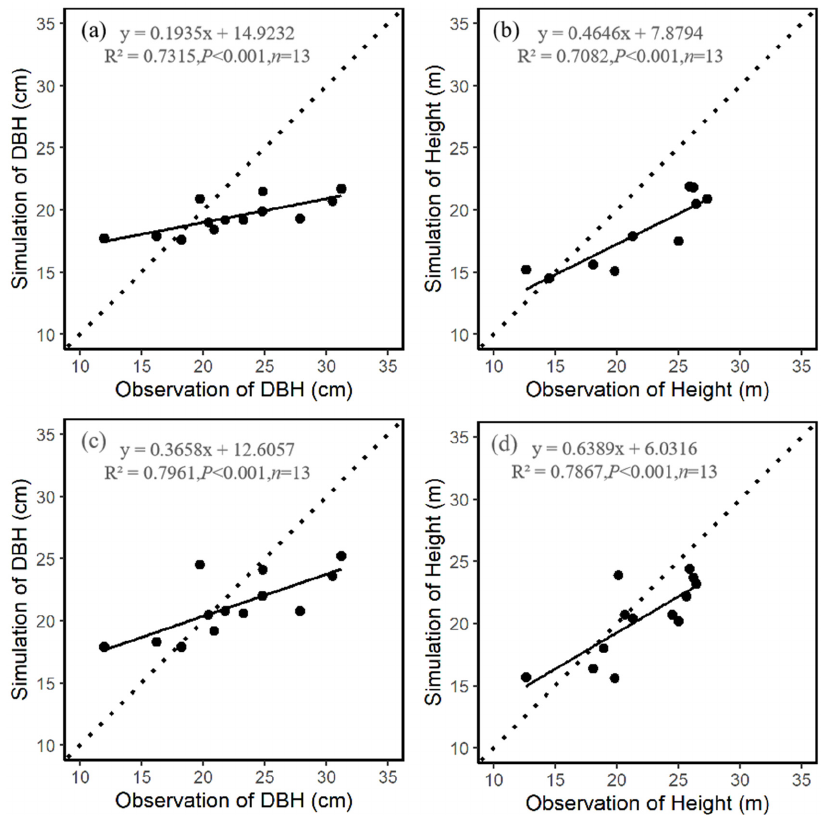
Figure 1. Comparisons between simulations for the original model ( a , b ) and modified model ( c , d ), and the observed diameter at breast height (DBH, cm) and tree height (m), respectively, for 10 poplar stands with different densities in northern Jiangsu Province. The solid line represents the fitting line and the diagonal line represents the 1:1 line. Table 3. Performance of the original and modified TRIPLEX-Management model.